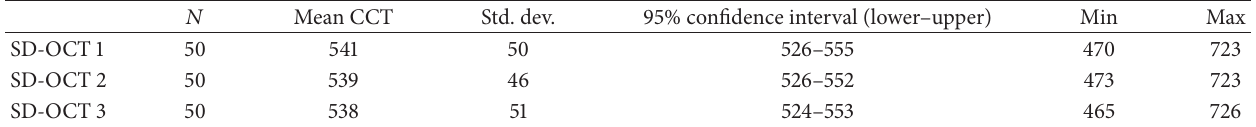
Table 1: Comparison of 3 measurements by SD-OCT in 50 premature infants.